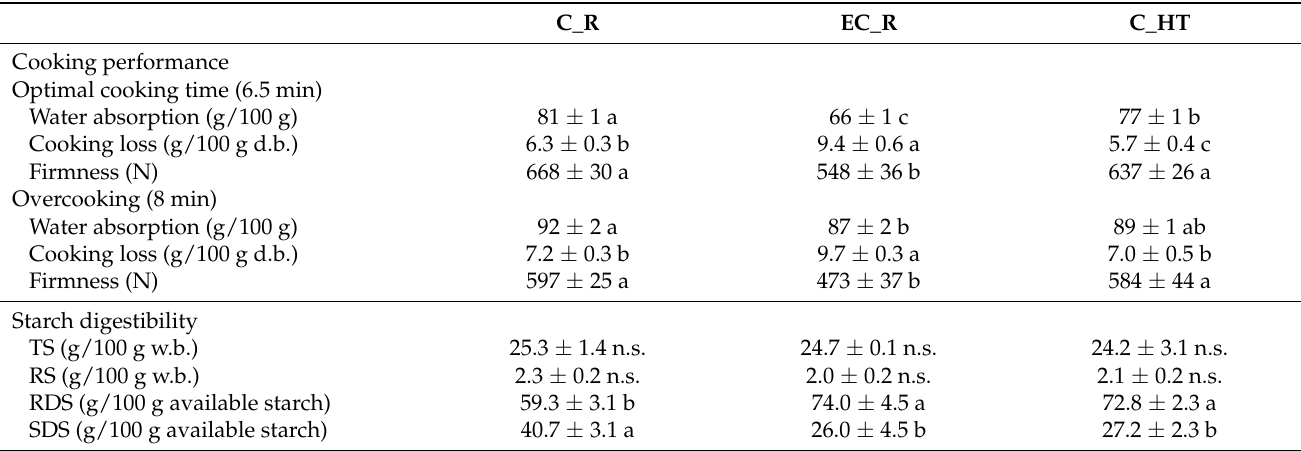
Table 3. Cooking behavior and starch digestibility of pasta from red